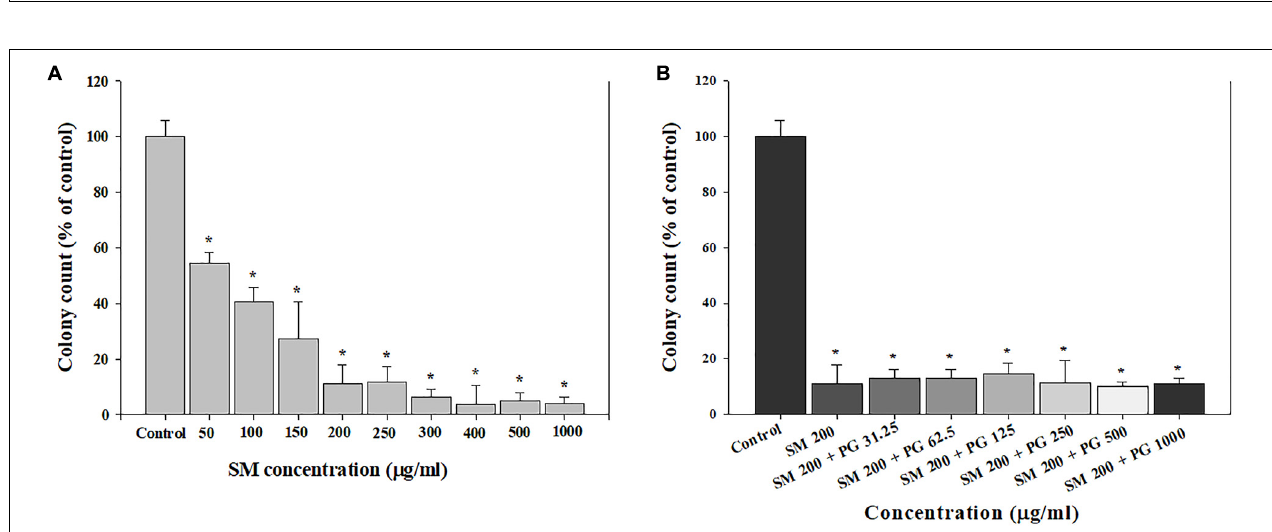
FIGURE 2 | The inhibition of cell colony formation induced by the SM in human lung epithelial cells. (A) SM and (B) SM+PG mixture. A549 cells were exposed to chemicals for 7 days. The values are reported as the mean ± SE (Student’s t -test, ∗ P < 0.05 vs. control).